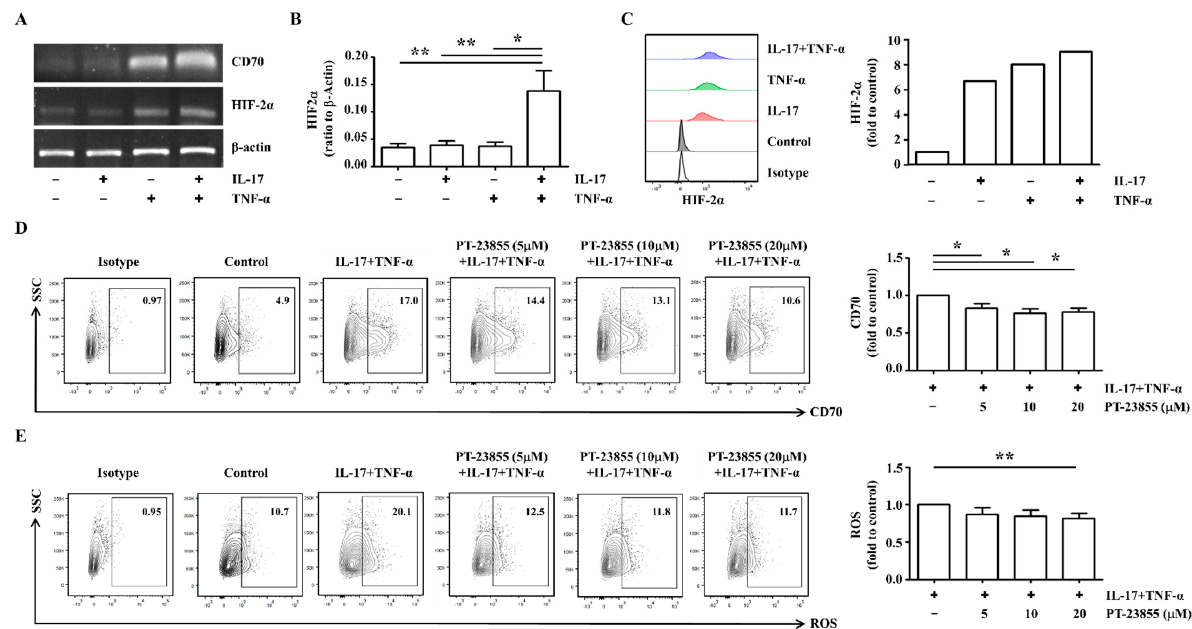
Figure 4. CD70 expression in RA FLS is downregulated by HIF-2 α -specific inhibition. ( A ) RA FLS were cultured with or without IL-17 (5 ng/mL) and TNF- α (5 ng/mL) for 24 h. ( B ) RA FLS ( n = 6) were cultured with or without IL-17 (5 ng/mL) and TNF- α (5 ng/mL) for 24 h. mRNA levels of CD70 or HIF-2 α were assessed by RT-PCR, using β -actin as the housekeeping gene. Statistical differences were determined using one-way ANOVA. ( C ) To analyze the intracellular expressions of HIF-2 α , RA FLS were cultured with or without IL-17 (5 ng/mL) and TNF- α (5 ng/mL) for 24 h. Following fixation and permeabilization, RA FLS were stained using rabbit anti-human HIF-2 α with FITC-conjugated anti-rabbit IgG secondary antibody. Data from one representative experiment are presented (left). The averages of HIF-2 α expression are displayed as fold change of the MFI compared to control (right). ( D ) RA FLS ( n = 4) were cultured with or without IL-17 (5 ng/mL) and TNF- α (5 ng/mL) for 24 h. To inhibit HIF-2 α , cells were co-treated with 5, 10, or 20 µ M of PT-2385 for 24 h. To analyze surface expression of CD70, flow cytometry analysis was performed using PE-conjugated anti-CD70. Data from one representative experiment are presented (left). The averages of CD70 expression are displayed as fold change of the MFI compared to cytokine-stimulated cells (right). Statistical analysis was performed using a Mann–Whitney test. ( E ) RA FLS ( n = 5) were cultured with or without IL-17 (5 ng/mL) and TNF- α (5 ng/mL) for 24 h. To inhibit HIF-2 α , cells were co-treated with 5, 10, and 20 µ M of PT-2385 for 24 h. To analyze ROS levels, flow cytometry was performed using DCFDA. Data from one representative experiment are presented (left). Average ROS levels are displayed as fold change of the MFI compared to cytokine-stimulated cells (right). Statistical analysis was performed using a Mann–Whitney test. The bar represents the mean. * indicates p < 0.05; ** indicates p <